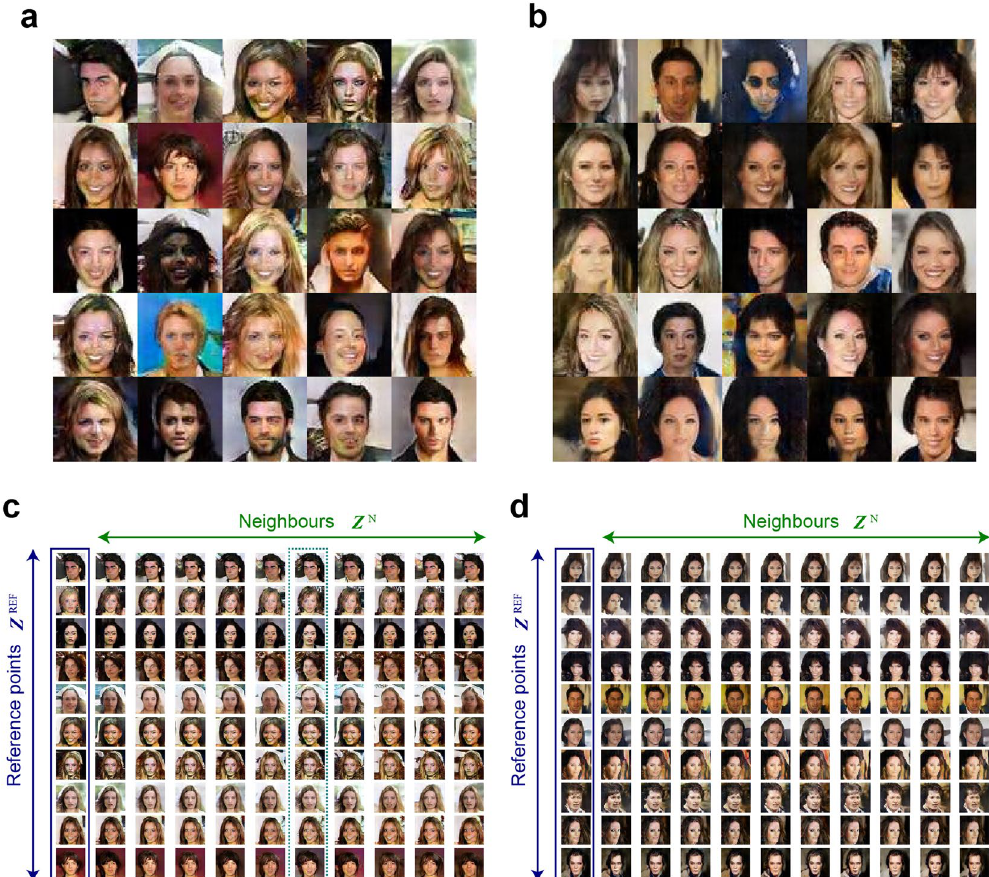
Figure 3. Comparison of images generated using pseudorandom numbers and chaos. Examples of face images generated with training using ( a ) pseudorandom numbers and ( b ) chaotic sequences. Proximity analysis of images generated with training using ( c ) pseudorandom numbers and ( d ) chaos. In generating those images, CelebA datasets 8 were